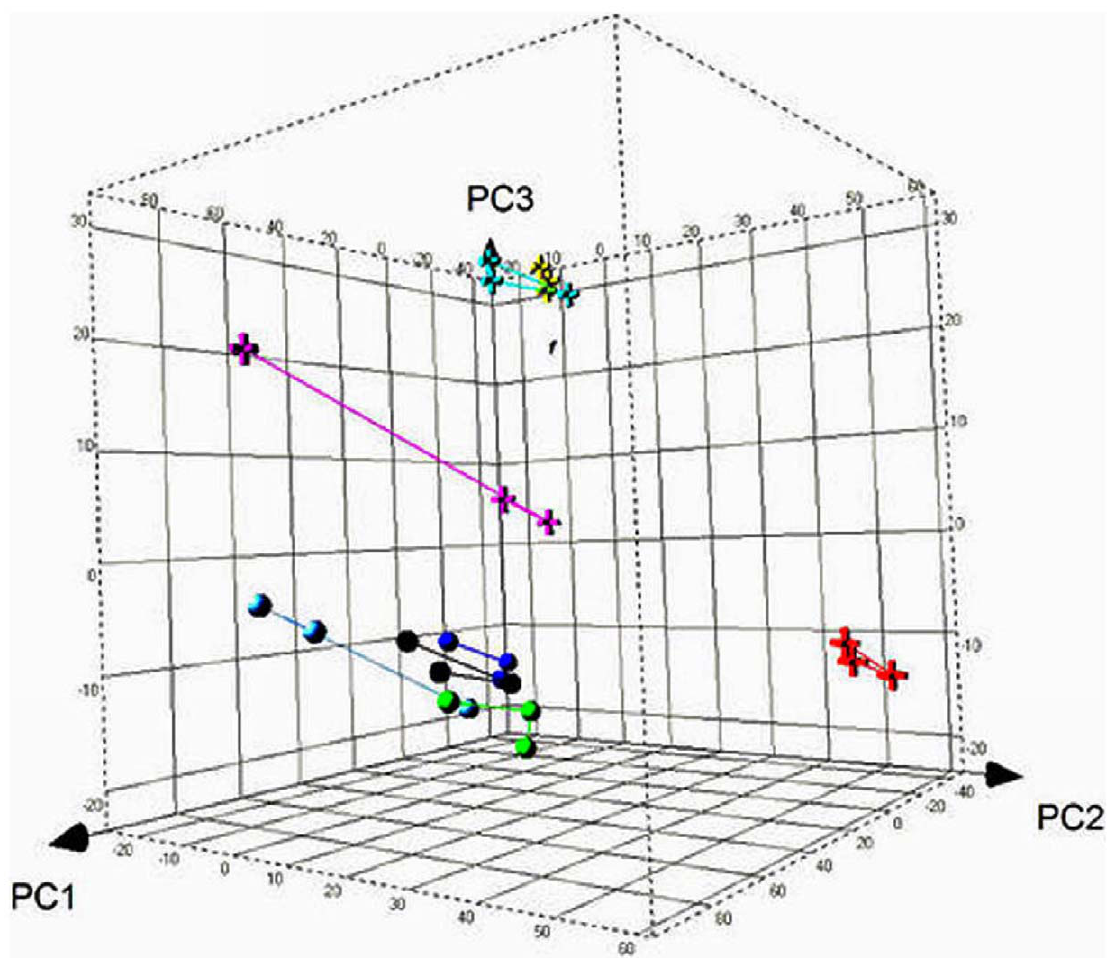
Figure 2. Heatmap of correlationship between demography variables and blood cell count measures. The Spearman’s Rank Correlation Test was performed to assess the correlationship between age, gender, BMI and blood cell counts. The absolute values of correlation coefficients were represented as the heatmap with red colour indicating high correlations and green colour indicating low correlations between the variables.